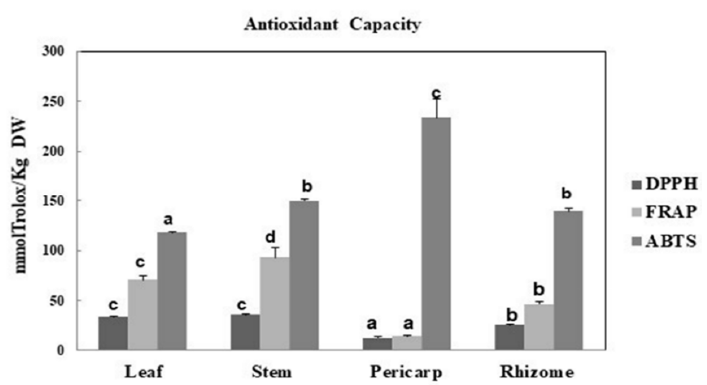
Figure 3. Antioxidant activities, expressed as mmol Trolox equivalent/Kg of dry weight in A. acutifolius leaf, stem, pericarp and rhizome ethanolic extracts, determined by DPPH, FRAP and ABTS assays. DPPH: DPPH radical scavenging activity; FRAP: Ferric reducing antioxidant power; ABTS: ABTS radical scavenging activity. Results correspond to the mean ± standard deviation of three replicates. Different letters (a–d) indicate that the values are significantly different ( p < 0.05). The comparison is for different samples with the same method.